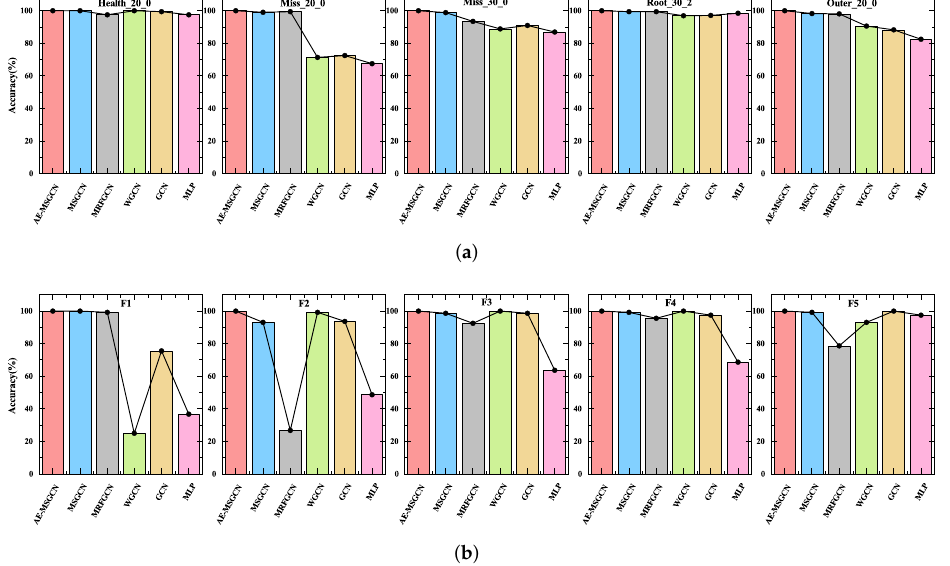
Figure 11. Detailed display of diagnosis results for the selected faults. ( a ) SEU dataset, ( b ) CMO